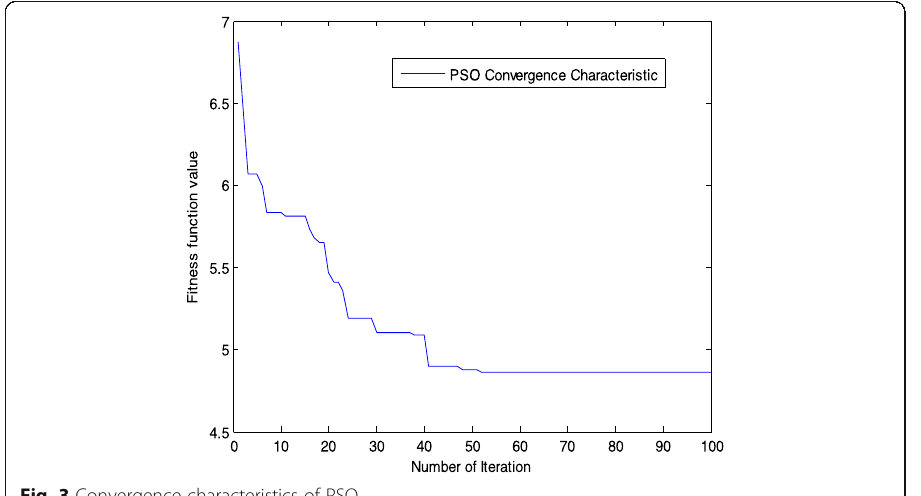
Fig. 3 Convergence characteristics of